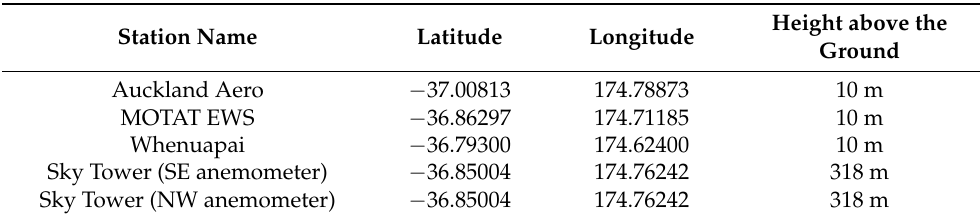
Table 1. List of the measurement stations used for validation along with their coordinates and heights above the ground surface.